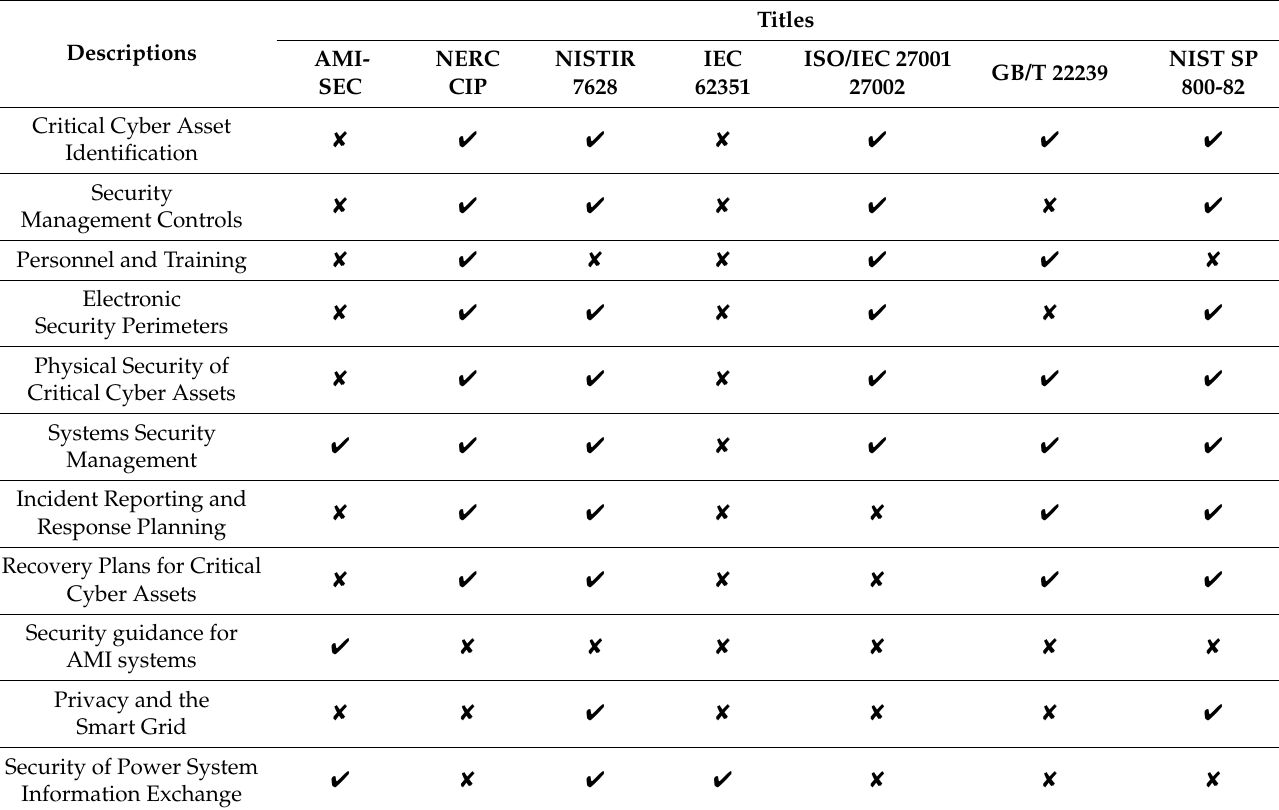
Table 1. Review of Standards and Protocols of